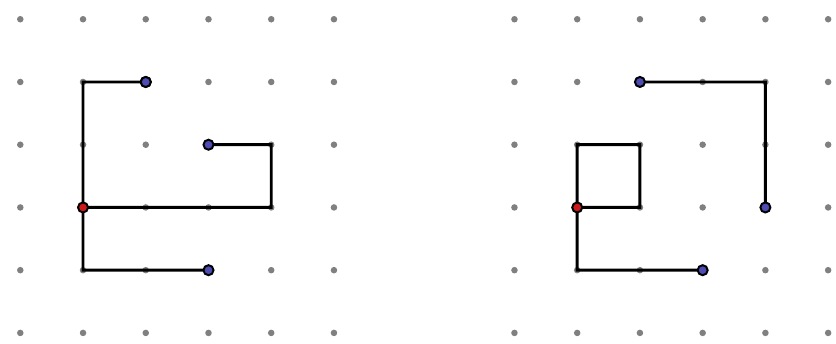
Figure 5 . Two configurations that scale like H 3 W 3 (both made with eleven bonds which thus give an extra factor of K 11 ). The blue dots represent end points weighted by H , while the red dot represents a vertex v weighted by W . The configuration on the left contains a single cluster while 3 3 the configuration on the right contains